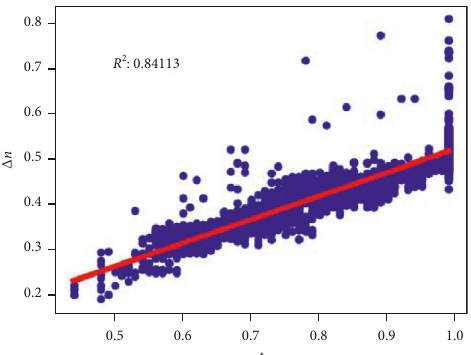
Figure 5: (a) Visualization of line segments for constructing the observation, with the lengths of 10 lines taken as an observation. (b) Visualization of l and r for calculating the imbalance penalty. Table 1: Hardware specification used in experiments.